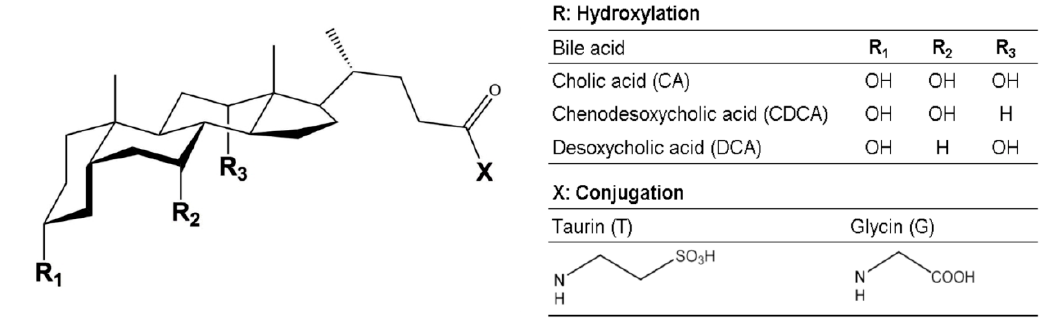
Figure 1. Chemical structure of primary and secondary bile acids mainly abundant in human bile.